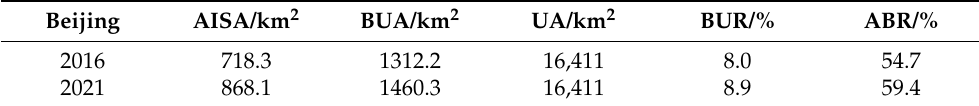
Table 6. Area values from